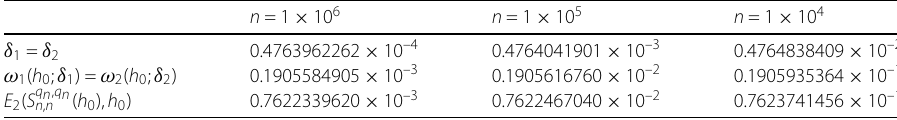
Table 2 The approximation error of S q n , q n n , n ( h 0 ) to h 0 by means of the partial modulus of continuities n = 1 × 10 6 n = 1 × 10